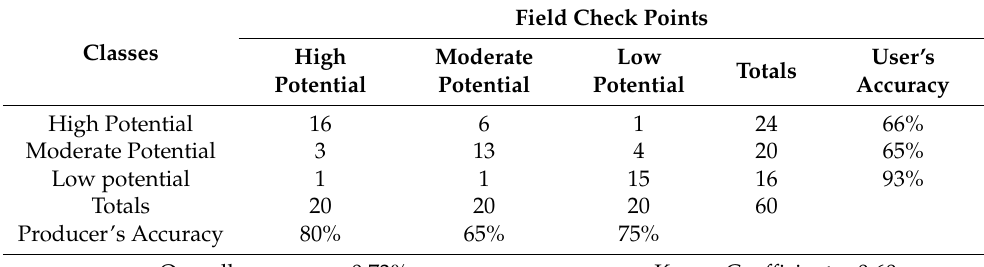
Table 6. Confusion matrix for mineral potential maps versus field